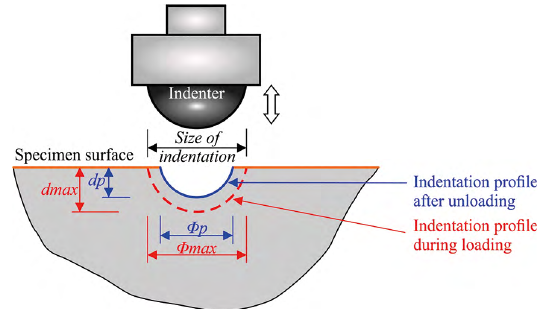
Figure 1. Schematic of the ball indentation test.